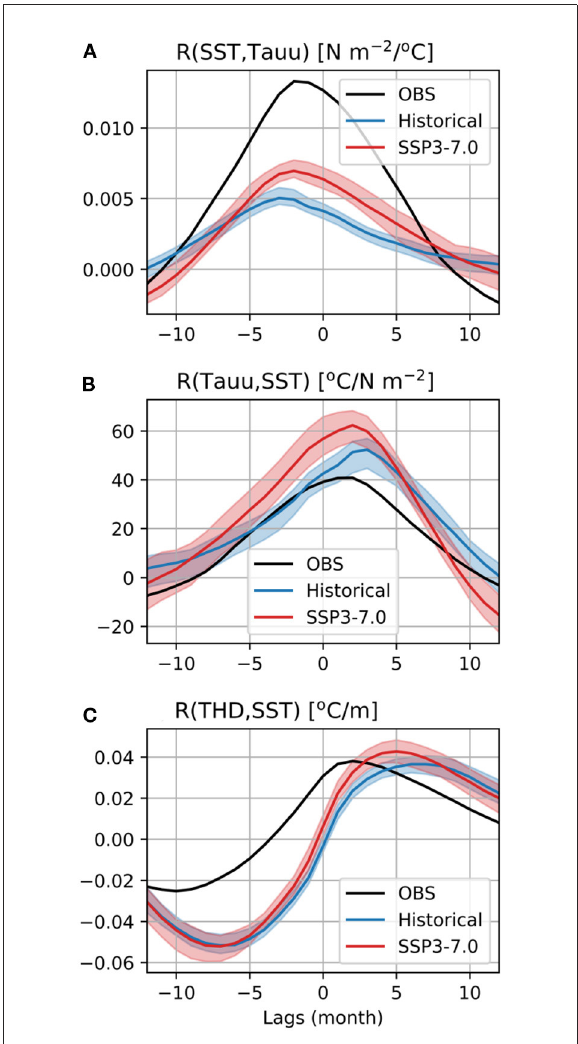
FIGURE3 Lag-regression coefficients of ENSO variables related to the key ENSO processes, and their changes under global warming. (A) Regression of the Niño-4 zonal wind stress index onto the Niño-3 SST index (related to the atmospheric Bjerknes feedback), (B) regression of the Niño-3 SST index onto the Niño-4 zonal wind stress index (related to the zonal wind forcing of SST), and (C) regression of the Niño-3 SST index onto the Niño-3 thermocline depth index (related to the thermocline feedback). The colored thick curves represent the ensemble medians and the shadings indicate the respective 5–95% confidence intervals, both estimated from the 40 ensemble members. In each plot, the first variable leads the second variable at positive